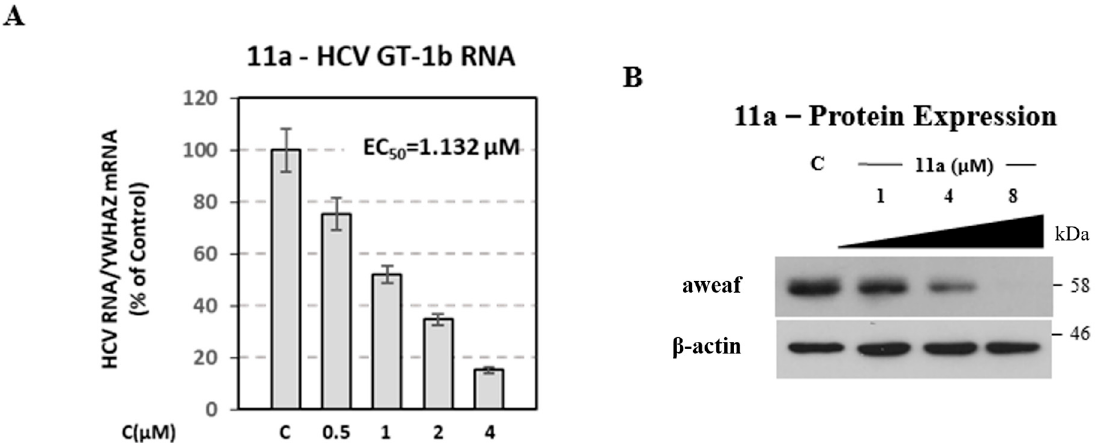
Figure 4. Inhibitory activity of analogue 11a on HCV RNA and protein expression levels of the subgenomic 1b (Con1) replicon. Huh5-2 cells were treated with serial dilutions of 11a or the solvent DMSO (control—C). ( A ) (+) strand HCV RNA was quantified by RT-qPCR. Values were normalized to the housekeeping gene 14-3-3-zeta polypeptide (YWHAZ) mRNA levels and expressed as percentage of those derived from cells treated with the solvent (control), which was set to 100%. Bars represent mean values obtained from three separate experiments in triplicate. Error bars represent standard deviation (SD). ( B ) Western blot analysis for the viral protein NS5A. β -actin was used as a loading control. A representative experiment of three independent replicates is shown.